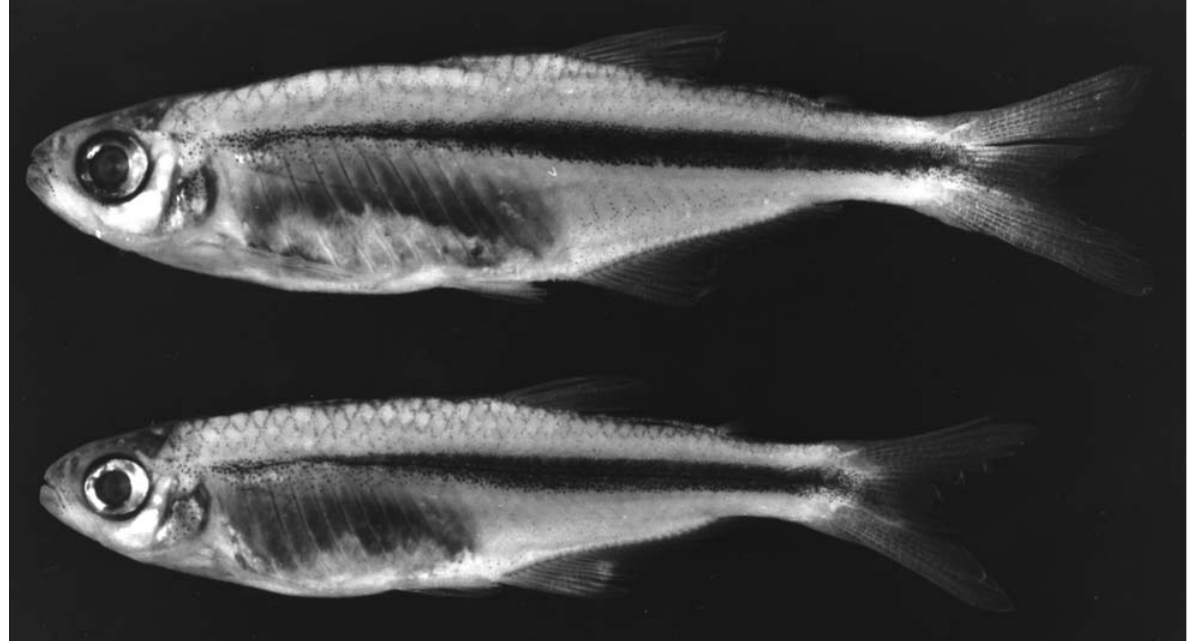
Fig. 22. Planaltina myersi , MNRJ 10634, a mature male (below), 32.5 SL and a female (above) 36.8 mm SL, Brazil: Distrito Federal, córrego Fumal, where crosses road between Brasília and Planaltina, near Planaltina, about 15°20’S 47°50’W, collected 11 Apr. 1982 by L. E. de Macedo Cardoso. Note that the pale area on the anal fin of the male is where the anal-fin hooks are concentrated and the whitish color is due to the presence of anal-fin club